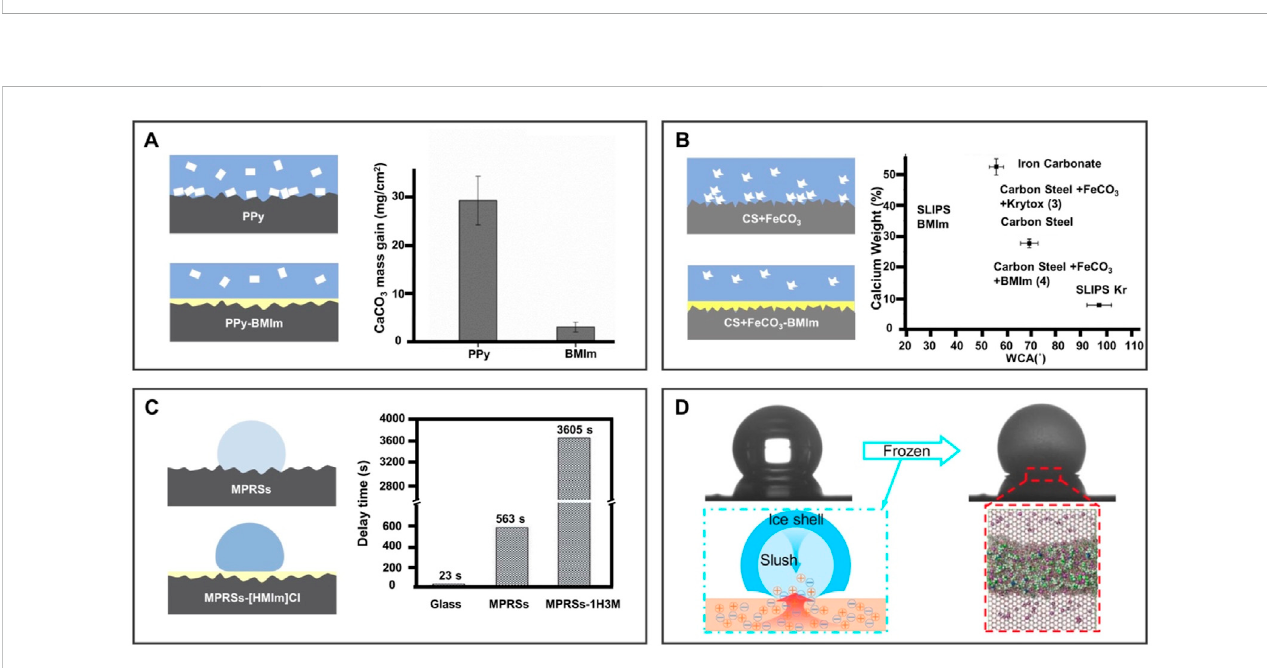
FIGURE 8 BILIMs for anti-solid fouling. (A) Low surface energy lubricant and BMIm were injected into the porous polypyrrole coating to reduce scaling. Reproduced with permission (Charpentier et al., 2015). Copyright 2015, Elsevier Inc. (B) BMIm-infused FeCO 3 layer of carbon steel increases hydrophobicity and reduces scale formation. Reproduced with permission (Saul et al., 2021). Copyright 2021, Informa United Kingdom Limited. (C) BMIm[PF 6 ] doped polyvinylidene fl uoride nano fi bers delay the freezing time of water droplets and reduced the crystallization temperature and ice adhesion strength of water droplets. Reproduced with permission (Rao et al., 2019). Copyright 2019, The Royal Society of Chemistry. (D) Ionogel surface inhibits ice nucleation, growth, and adhesion. Reproduced with permission (Zhuo et al., 2020). Copyright 2020, American Chemical